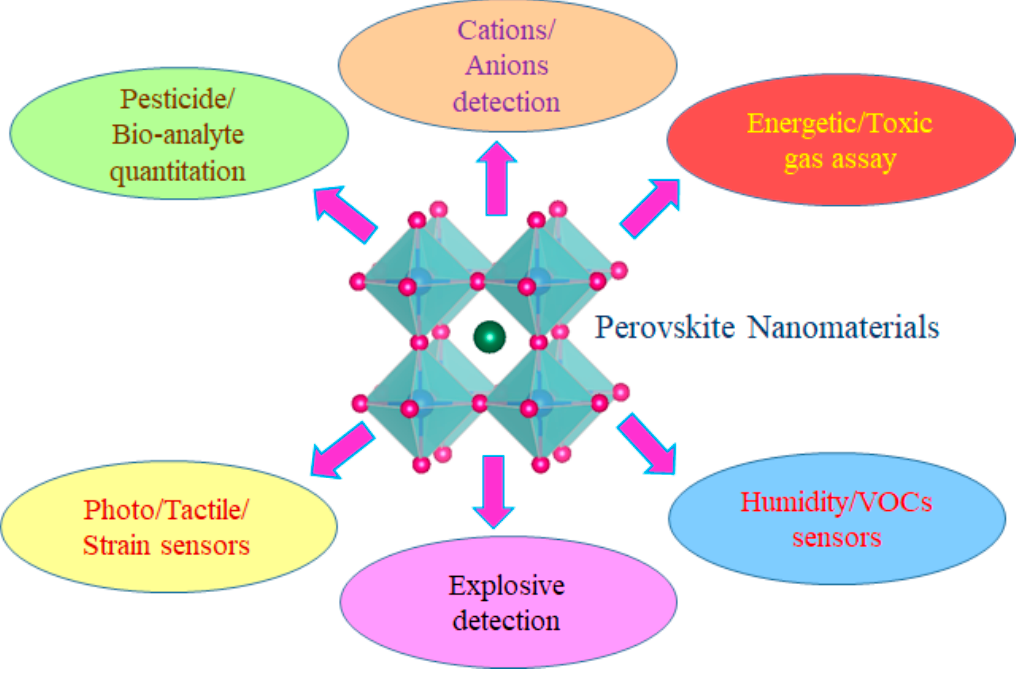
Figure 1. Schematic illustration of the sensory applications of perovskite nanomaterials.